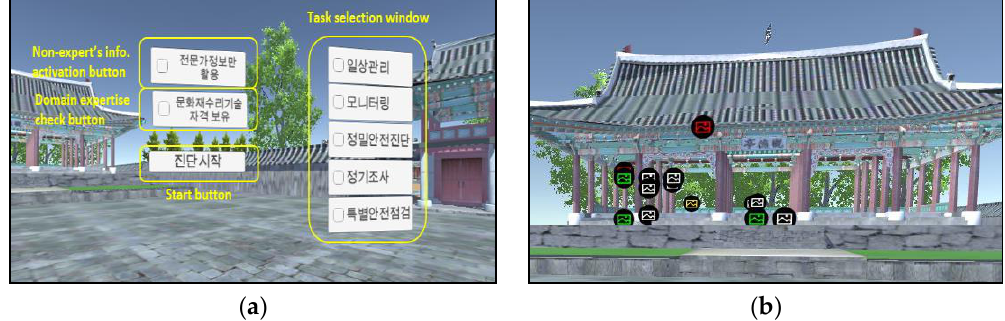
Figure 9. An example of contents filtering according to domain expertise and task: ( a ) a log-in screenshot and ( b ) filtered contents of remote diagnosis application.